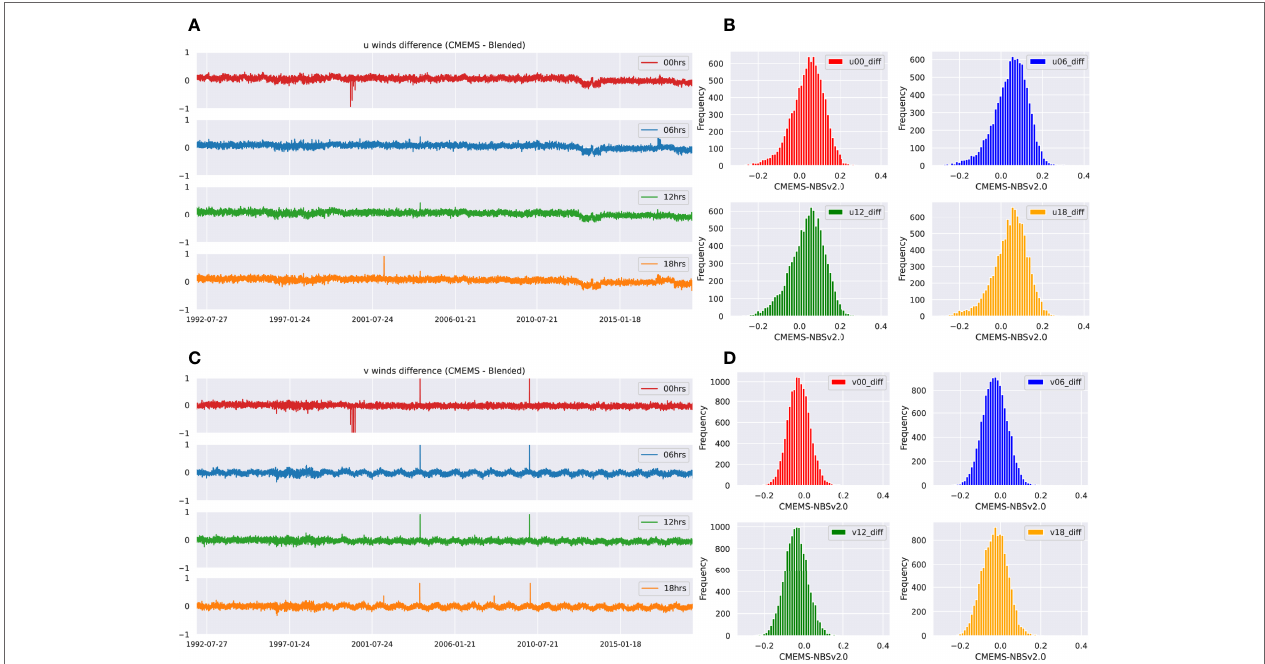
FIGURE 6 | Time series of global annual mean of difference between Copernicus Marine Environment Monitoring Service (CMEMS) and National Oceanic and Atmospheric Administration (NOAA) National Centers for Environmental Information (NCEI) blended wind. A time series of daily global mean in the difference field (CMEMS—NOAA/NCEI blended sea winds) also shows that both the products agree more or less with each other for the entire period of 1992 to 2018, (A) is for the u-component, and (C) is for v-component of wind. The different colors denote different synoptic times. A distribution curve (histogram) for all 6-hourly times is also provided for (B) the u-component and (D) the v-component of